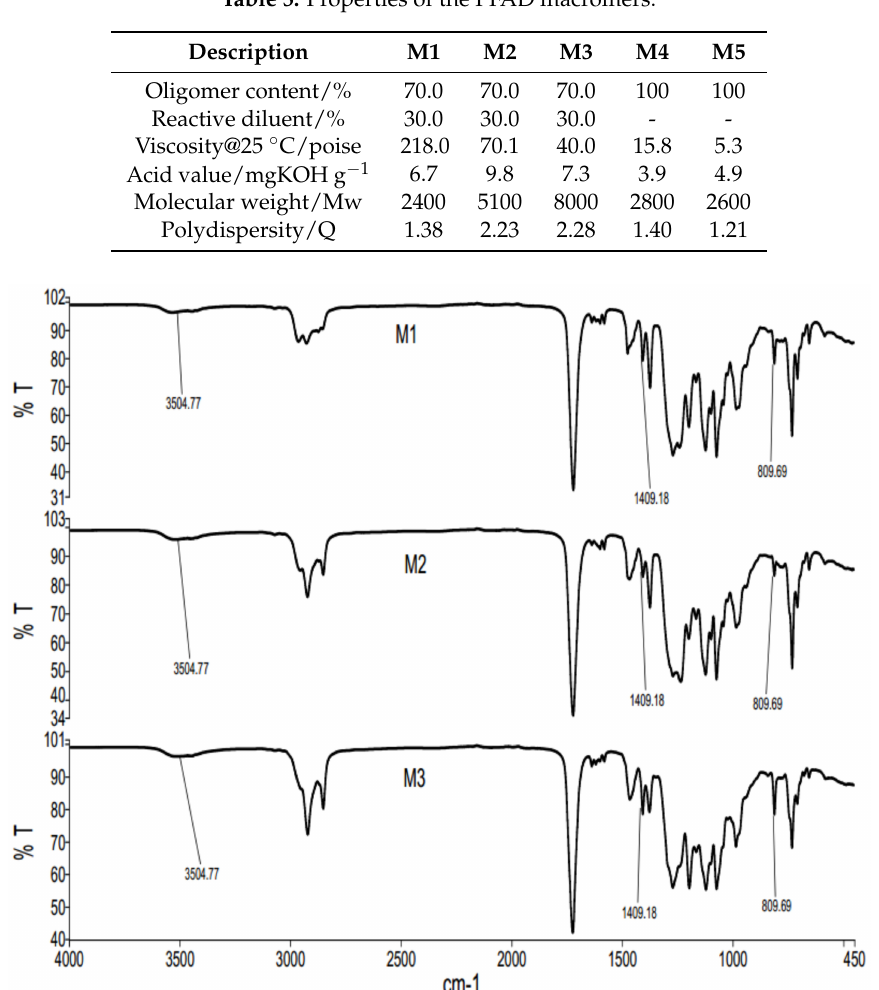
Table 5. Properties of the PFAD macromers.